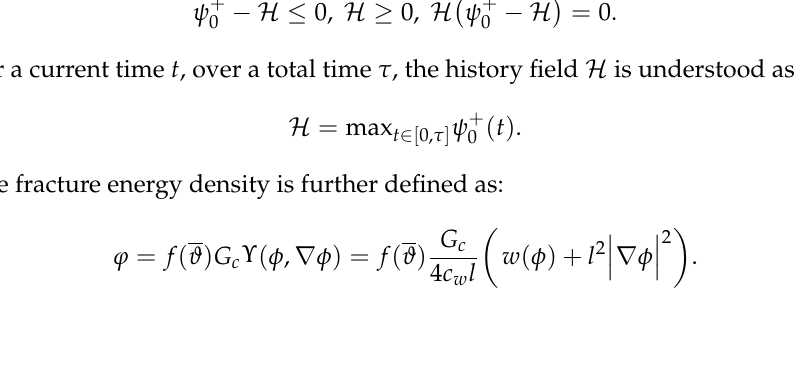
Figure 3. Schematic representation of a solid body. ( a ) Internal discontinuity boundaries, and ( b ) a phase fi eld approximation of the discrete discontinuities.